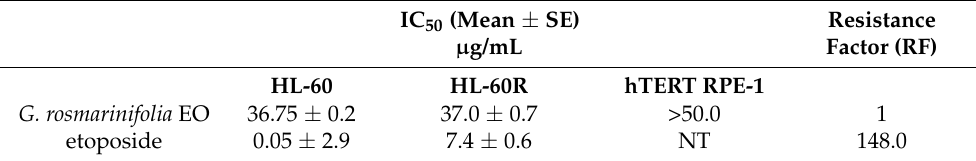
Table 1. IC 50 values and resistance factors of G. rosmarinifolia EO and etoposide in the cell